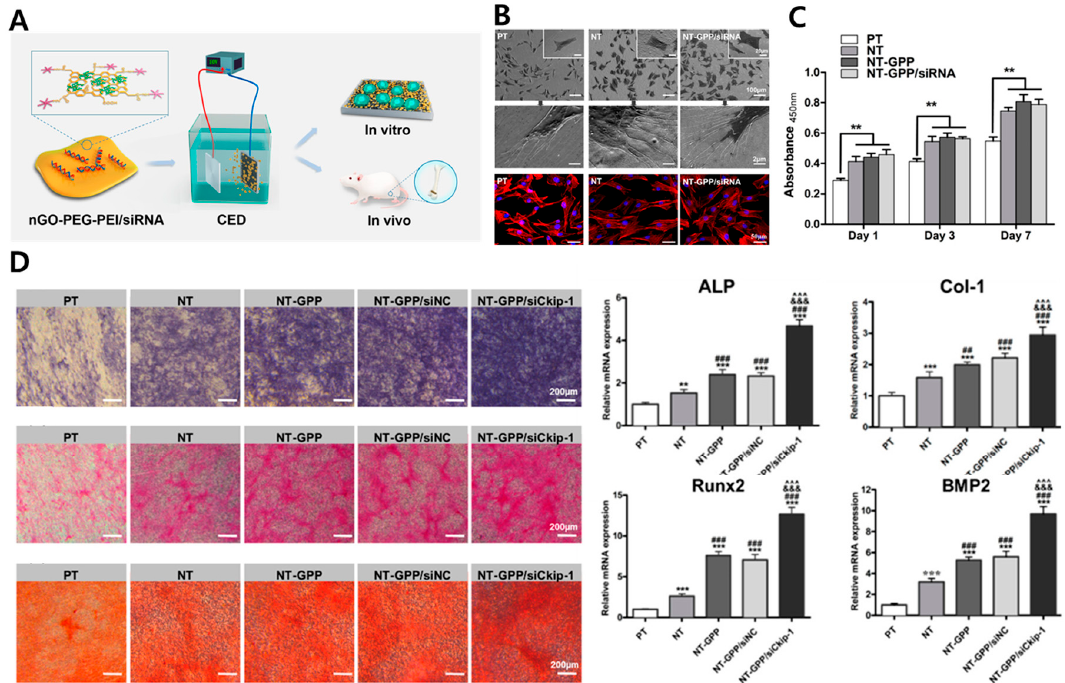
Figure 4. GO-PEG-PEI/siRNA composite for facilitation of osteogenesis ( A ) schematic diagram of GO-PEG-PEI/siRNA composite. ( B ) Optical and fluorescence microscopy of MC3T3-E1 cells cultured on Wet polished Ti (PT), NT, and NT-GPP/siRNA substrate. ( C ) Proliferation assay ( D ) ALP activity (purple), collagen secretion (pink), and ECM mineralization (orange), and osteogenic gene expression of cells cultured on PT, NT, and NT-GPP/siRNA substrate. Each symbol represents significant difference between groups (** and *** p < 0.01 and 0.001 vs. PT. ## and ### p < 0.01 and 0.001 vs. NT. &&& p < 0.001 vs. NT–GPP. ˆˆˆ p < 0.001 vs. NT–GPP/siNC). Data reproduced from Ref. [81]. Copyrights ACS 2017.